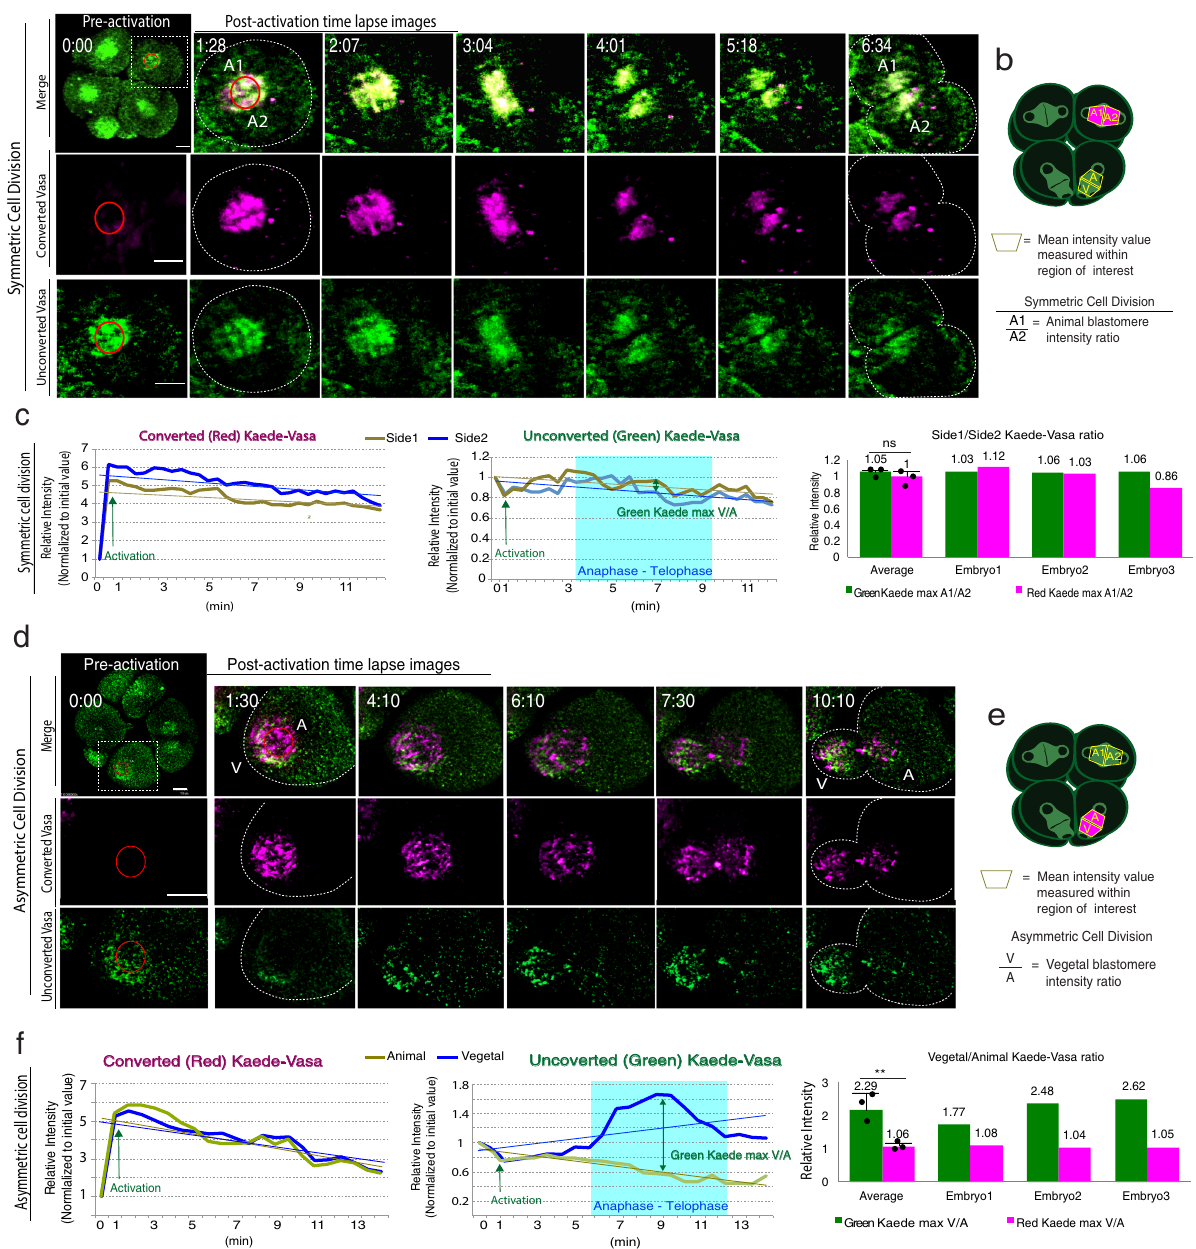
Fig. 2 Photoconverted and unphotoconverted Kaede-Vasa dynamics during symmetric (a) or asymmetric (d) cell division. a , d A whole Z-section of the cell (0.44 μ m per slice; ~90 slices in total) was imaged and analyzed every 1-min and presented as maximum 2D-projection. The upper leftmost column shows Kaede-Vasa expression prior to photoconversion (green) while the remaining columns are magni fi ed images of the region squared by a white dashed line. Images were taken at varying minute intervals as indicated in the corner, following photoconversion (magenta) during cell division. The area marked by a red circle is a photoconverted area (activation ROI). Kaede-Vasa levels were compared between the vegetal side (V) and the animal side (A) of the spindle during asymmetric cell division (B) or both sides of animal blastomeres (A1 and A2) during symmetric cell division (A). Scale bars = 10 μ m. b , e A cartoon diagram depicting a measurement area and protocol for comparing fl uorescent signal intensity across the mitotic spindles in either the animal ( b ) or vegetal blastomeres ( e ). Photoconversion was performed at an 8-cell stage metaphase. The major photoconverted area (magenta) typically appears in a trapezoid by following the shape of the spindle, which is labeled as A, V, A1, or A2 and indicates the area of the intensity measured (Detection ROI), respectively. The relative intensity of A1 over A2 for symmetric cell division and V over A for asymmetric cell division was compared and shown in graphs ( c ) and ( f ). c , f Kaede-Vasa intensity level during symmetric ( c ) and asymmetric ( f ) cell division was measured for detection ROI and normalized to its initial value. The green Kaede-Vasa was maximum ~2.29 folds higher in the vegetal side (V) compared to the animal side (A) of the spindle during asymmetric cell division, whereas nearly equal in both sides of the spindles (A1 and A2) during symmetric cell division ( p -value, 0.0094). All experiments were performed at least three independent times and the representative analyses are shown ( n = 3 each). Unpaired t -test was used for all statistical analyses in this fi gure. ** p < 0.01. Columns represent means ± SD or SEM. Source data are provided as a Source Data fi